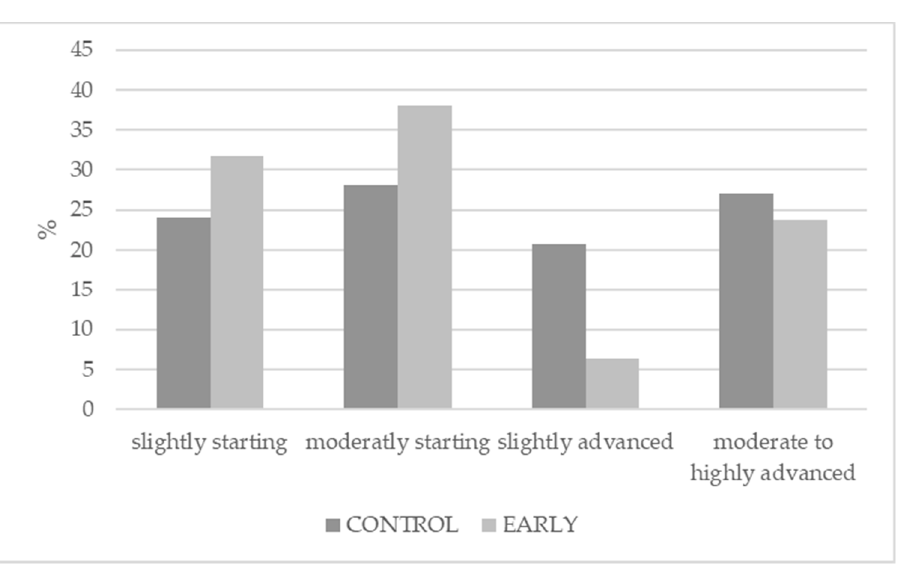
Figure 3. Atrophication classification according to immunization scheme.